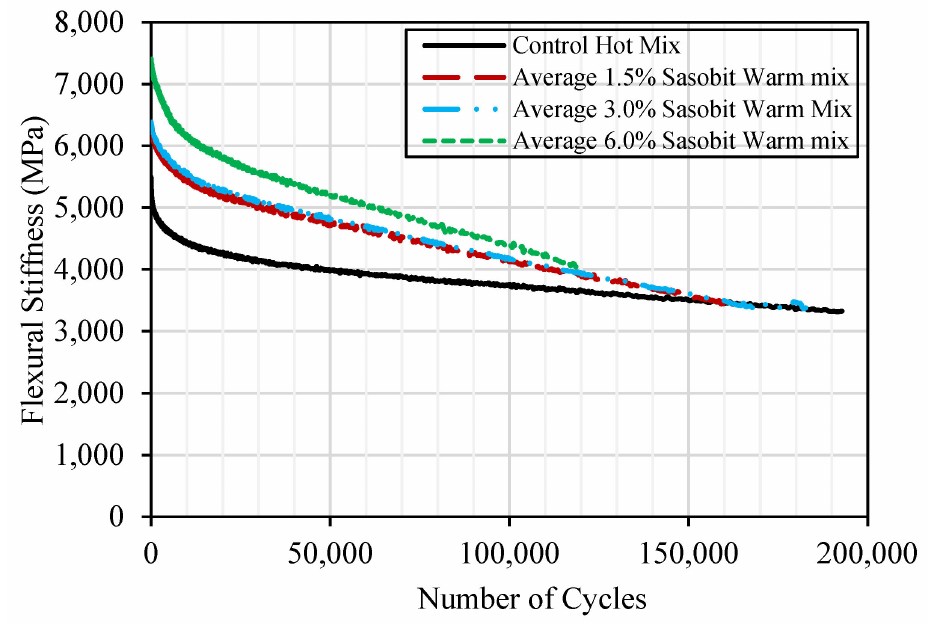
Figure 12. Comparison of average fatigue resistance for HMA and WMA.